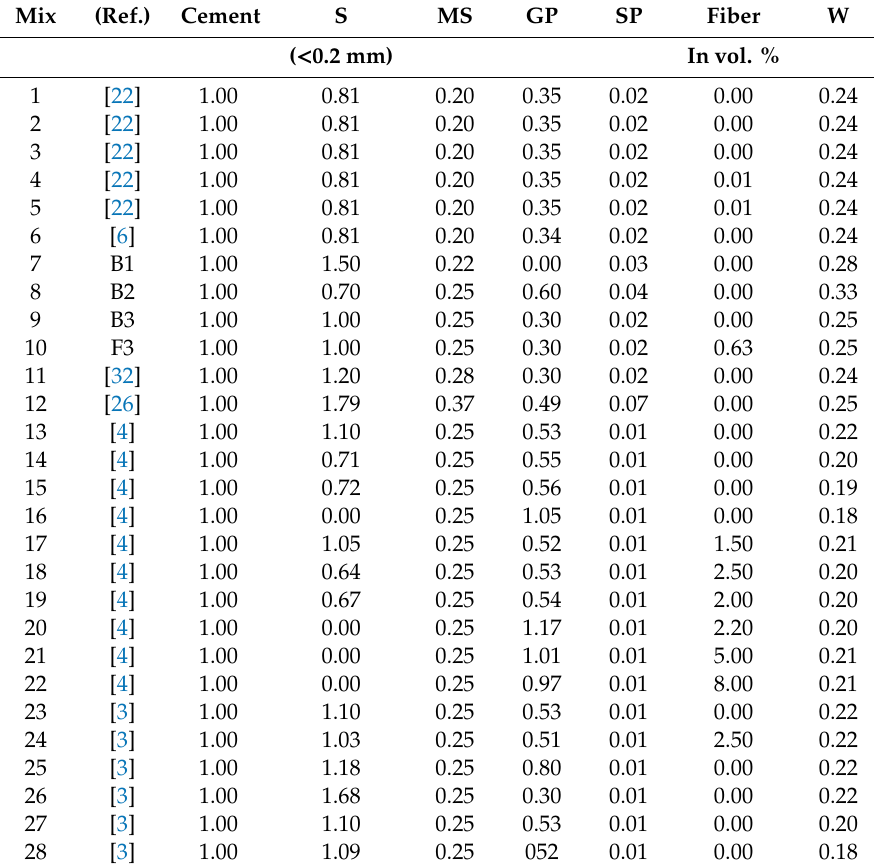
Table 4. Mixture proportions